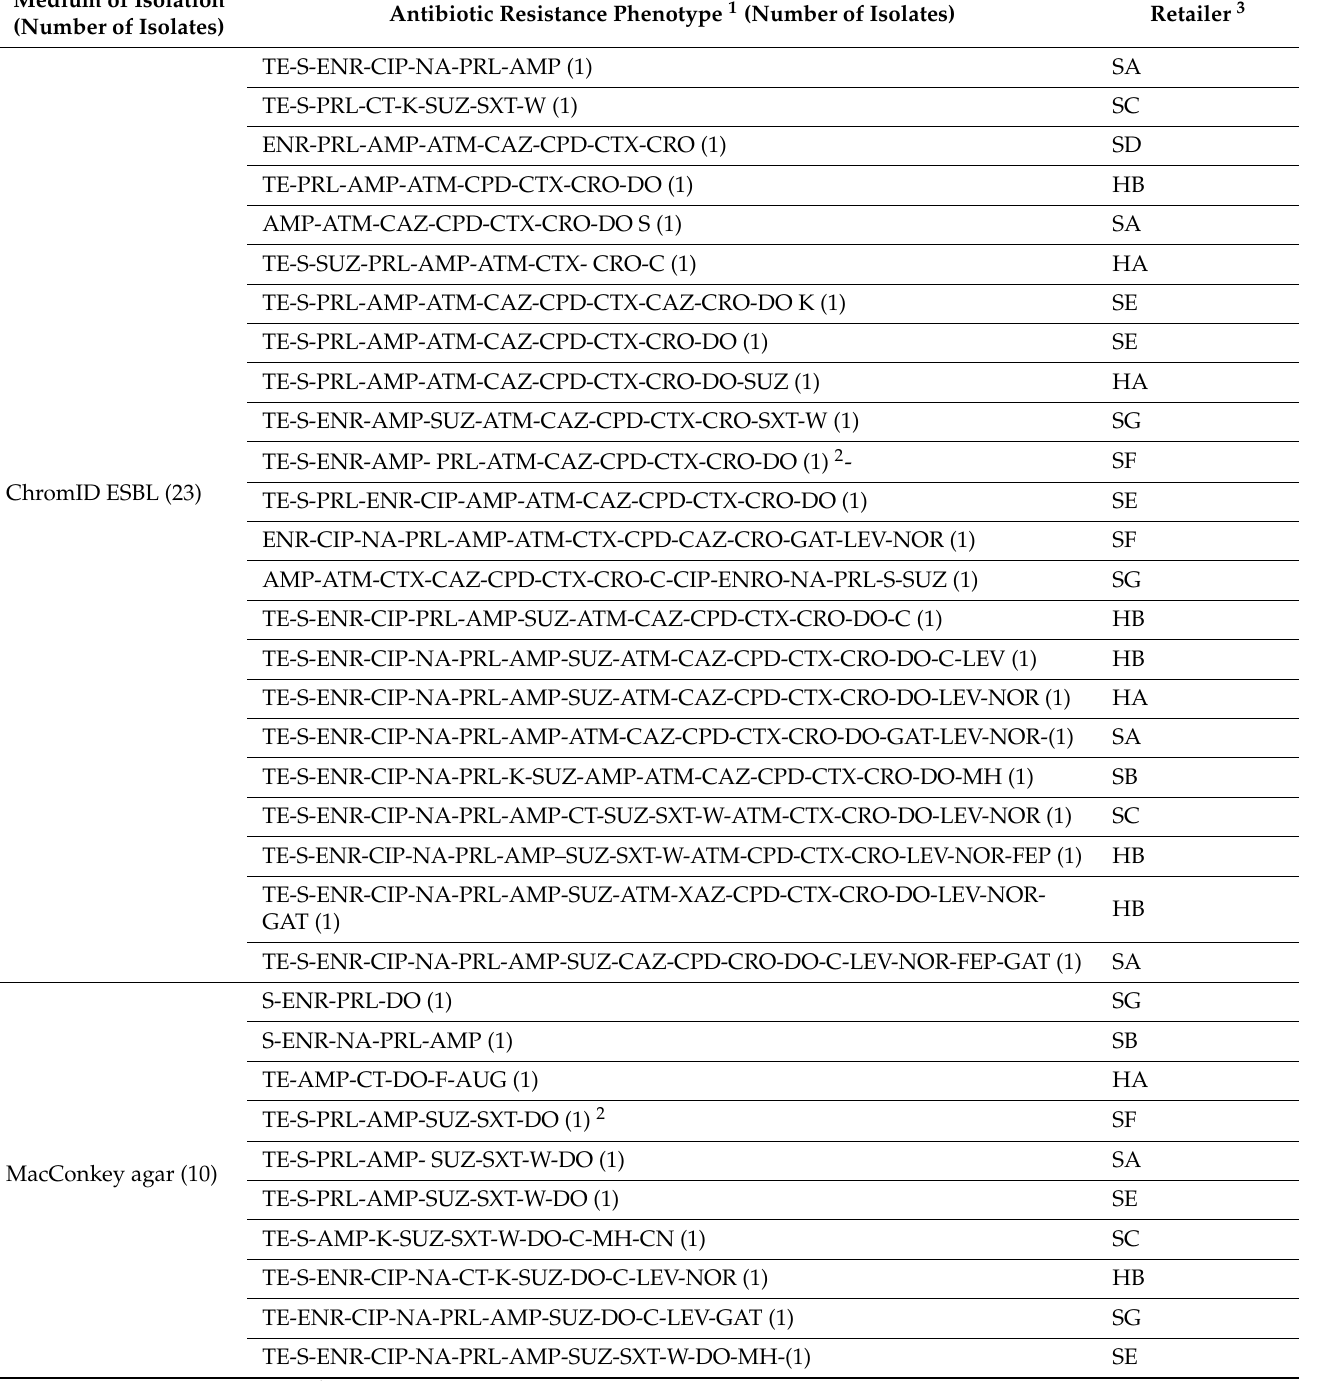
Table 5. Antimicrobial resistance phenotype of multi-resistant E. coli isolated from turkey